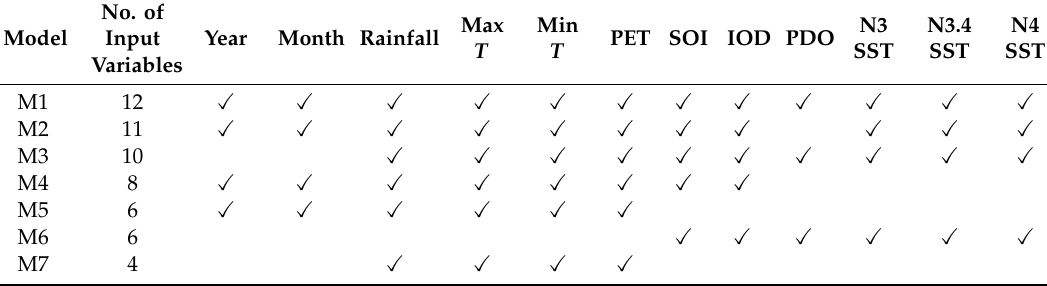
Figure 5. Cross-correlation between predictor variables with SPEI 12 at Gondar station. Table 3. Input variables proposed in the search for suitable models for predicting